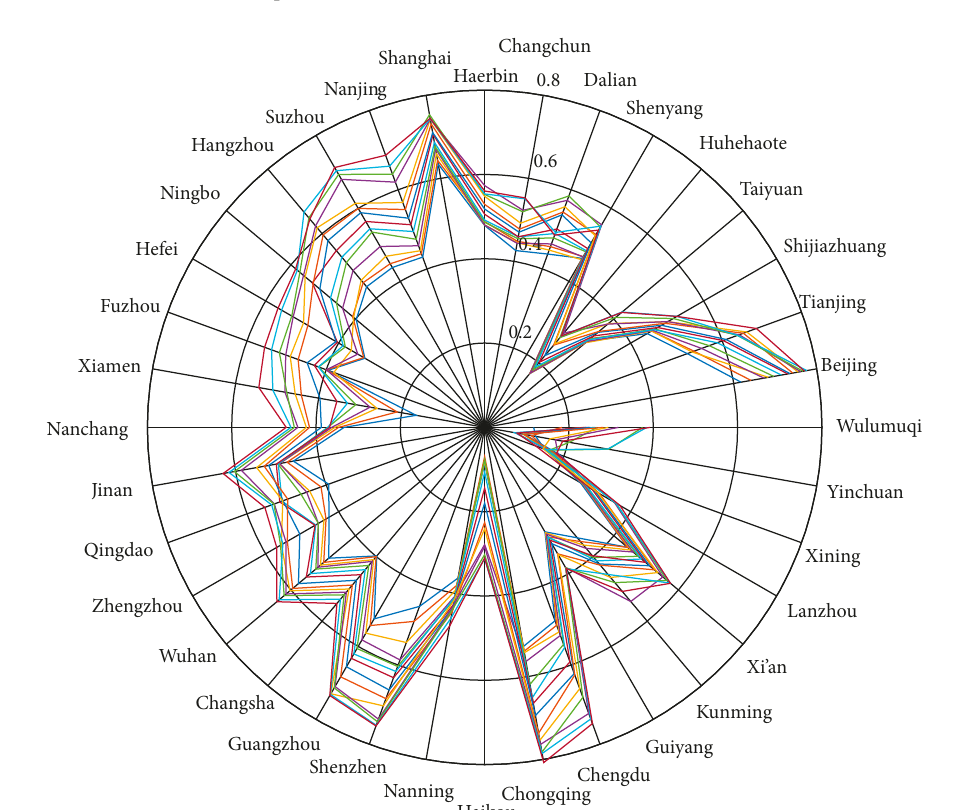
Figure 5: Radar diagram of CCD among UPE, economy, and